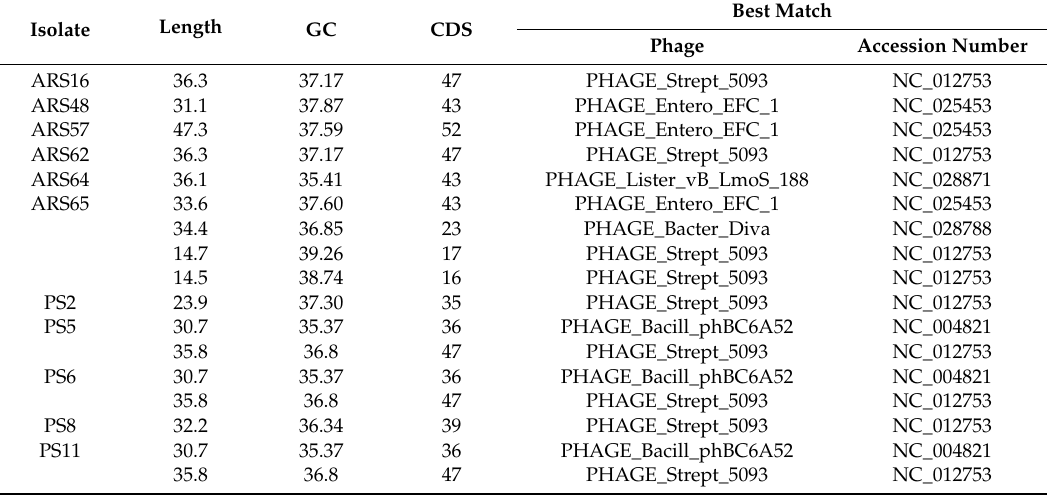
Table 2. List of intact phage in Enterococcus cecorum isolates from healthy and diseased chickens.